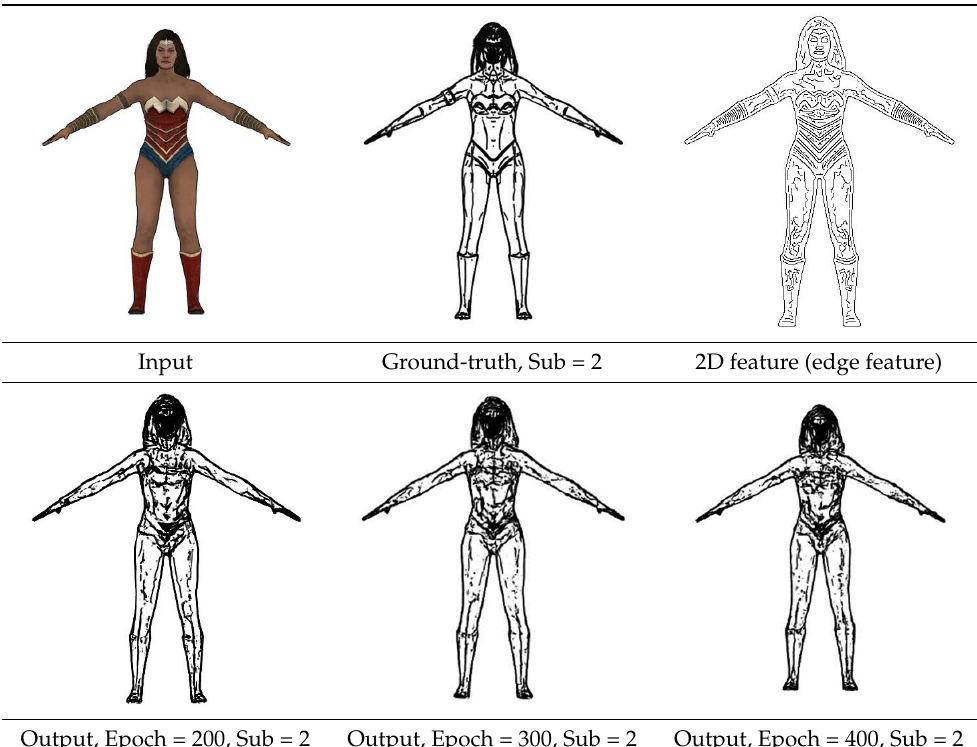
Table 4. Result of the line drawing extraction using a conditional GAN (Example 2).